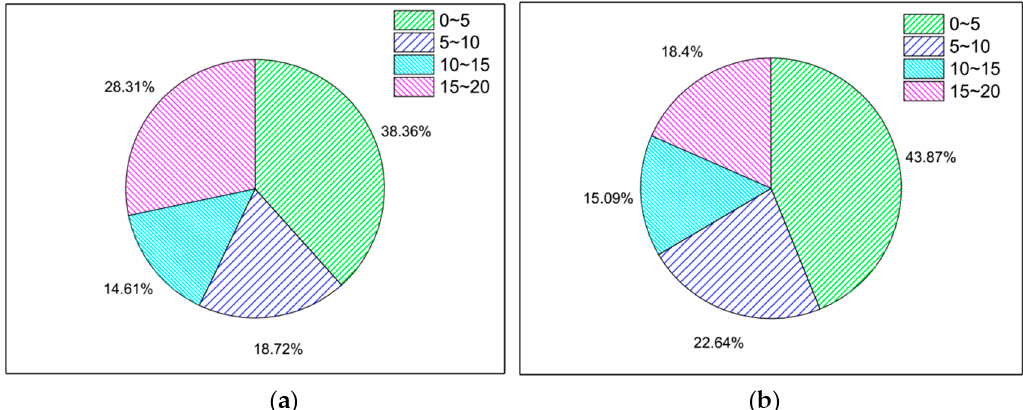
Figure 7. The pie distribution diagram of the length of time are detected within the fine grain time. ( a ) In the bus. ( b ) Out of bus.